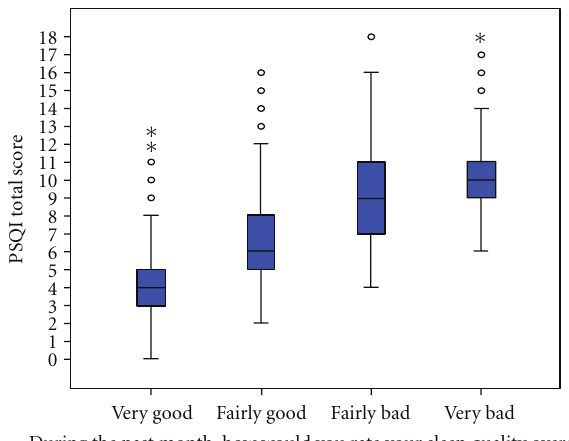
Figure 1: Comparison of Pittsburgh Sleep Quality Index scores and self-ratings of sleep